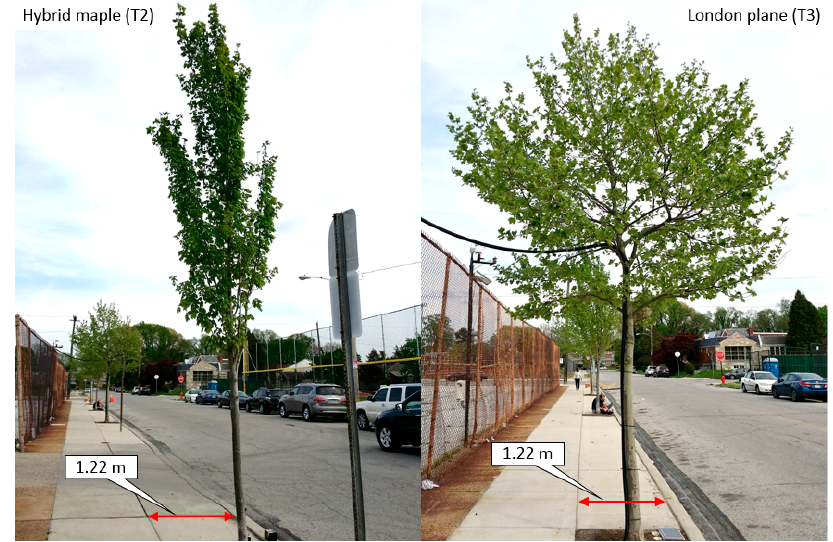
Figure 7. Canopies of A. × freemanii (T2) and P. × acerifolia (T3) in April 2017.